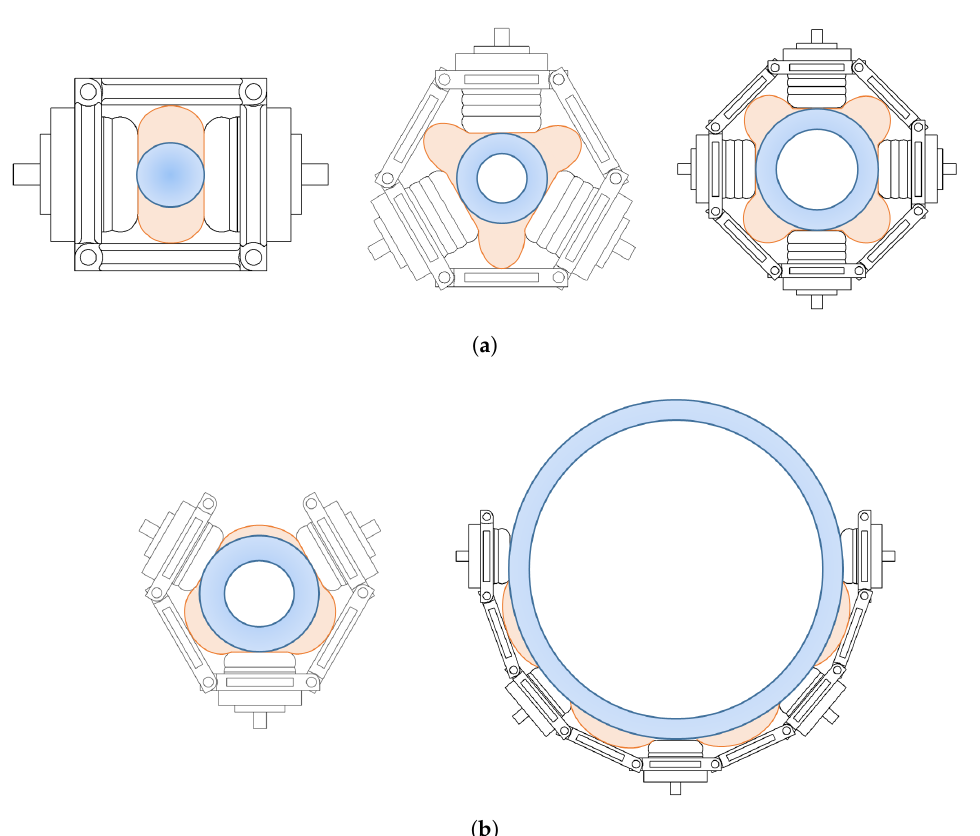
Figure 8. Feasible grip areas. ( a ) Closed gripper configurations. ( b ) Open gripper